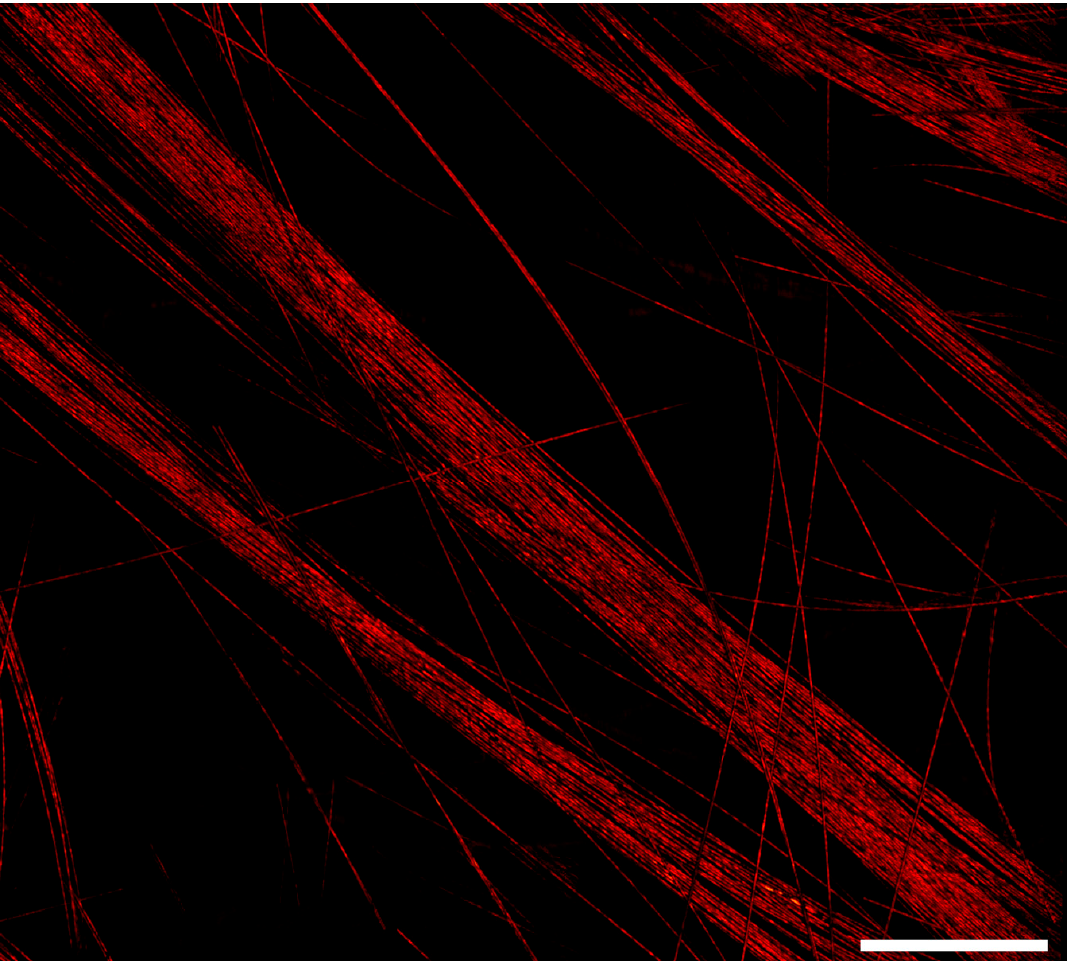
Figure 4. A 400-frame mosaic of carbon fiber networks, arranged in a 20 × 20 grid. Each frame has a field of view of 380 × 380 µm 2 , whereas the total field of view is 3 × 3 mm 2 . The image was acquired with a 532 nm excitation source operating at 40 kHz. Scale bar 500 µm.